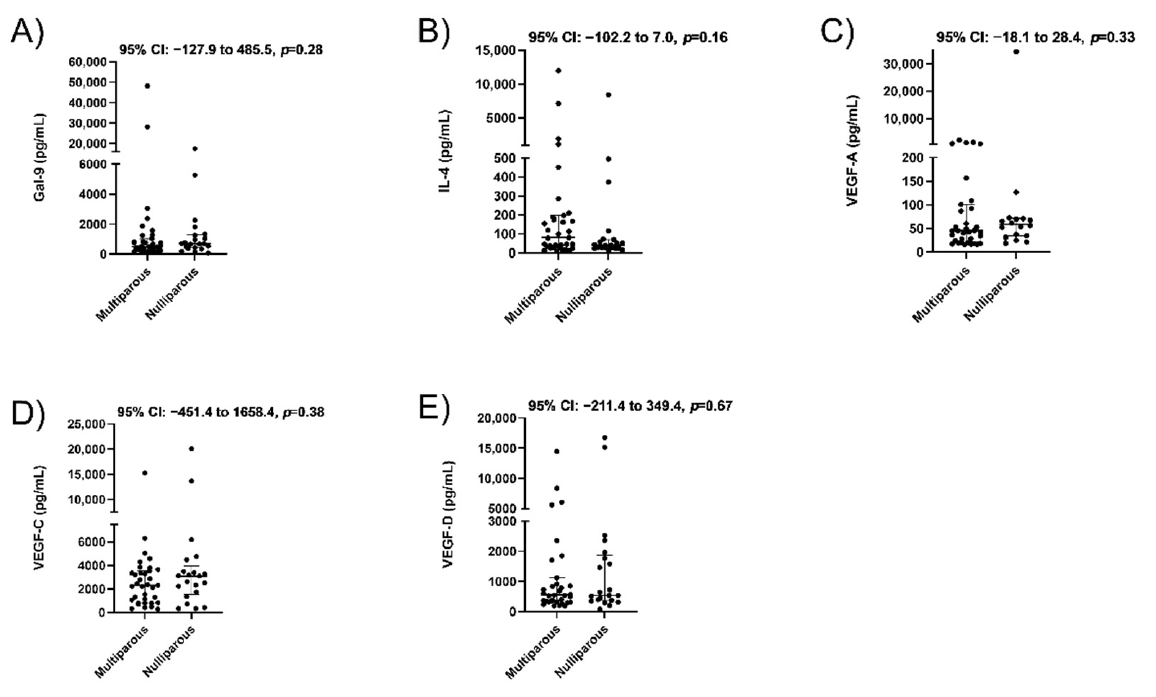
Figure 4. Plasma concentrations in maternal blood from women who are nulligravid ( n = 21) versus women with prior pregnancy ( n = 35). Concentrations of Galectin-9 ( A ), IL-4 ( B ), VEGF-A ( C ), VEGF-C ( D ), and VEGF-D ( E ) determined by ELISA. Data are displayed as median with interquartile range, along with 95% CI for the median difference between groups above each panel.